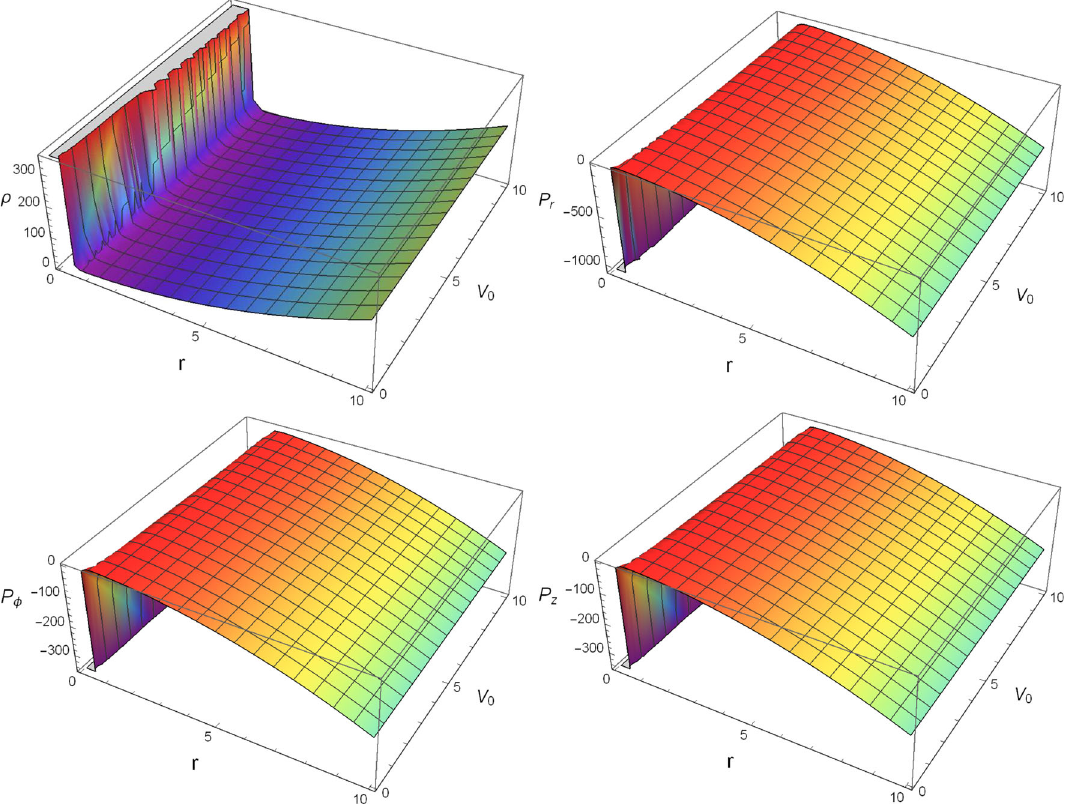
Fig. 33 This panel shows the graphical behavior of energy density (MeV/fm 3 ) , p r (MeV/fm 3 ) , p φ (MeV/fm 3 ) and p z (MeV/fm 3 ) w.r.t radial coordinate. CASE (Cosmic String)